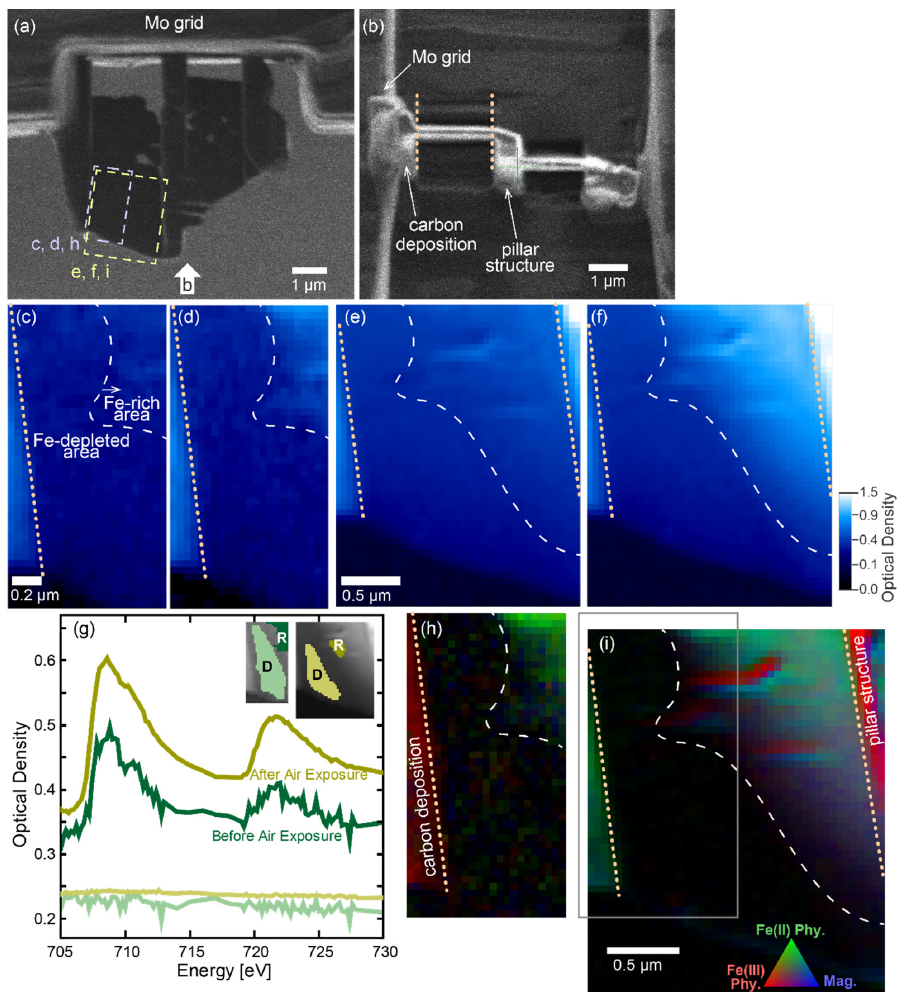
Figure 3. ( a , b ) Scanning ion microscope (SIM) image of the FIB thin section of the ferrous saponite particle. ( a ) SIM image view from the optical axis of STXM. The blue and yellow broken squares correspond to the areas scanned with STXM before (panels ( c , d , h )) and after (panels ( e , f , i )) air exposure, respectively. ( b ) SIM image view from the arrow direction in panel ( a ). The dotted lines show the left/right ends of the FIB thin section. ( c – f ) The optical density of X-rays collected before (panels ( c , d )) and after (panels ( e , f )) air exposure. The color represents optical density at 705.0 eV (no Fe absorption) (panels ( c , e )) and at 708.6 eV (due to Fe(II) and Fe(III) absorption) (panels ( d , f )). The orange dotted lines correspond to the range of thinned area shown in panel ( b ). The white broken curves represent the approximate boundary between the Fe-rich and Fe-depleted areas. ( g ) Typical XANES spectra at the Fe-rich and Fe-depleted areas. The areas used for extracting the spectra are shown in the top-right image with the same color for the index R (Fe-rich area) and index D (Fe-depleted area). ( h , i ) RGB map of the estimated composition using singular value decomposition (SVD) of XANES mapping before (panel ( h )) and after (panel ( i )) air exposure. Red, green, and blue represent the regions with presence of ferric smectite, ferrous saponite, and magnetite, respectively. The spectra of these three components were obtained by calibrating the reference spectra shown in Figure 2a using E ₀ to that of XANES spectra at the Fe-rich area shown in panel ( g ); that is, E ₀ = 707.8 eV for measurement before air exposure (panel ( h )) and E ₀ = 707.4 eV for measurement after air exposure (panel ( i )), respectively. The brightness and contrast were modified for clarity. The gray square in panel ( i ) corresponds to the scanned area before air exposure shown in panel ( h ).